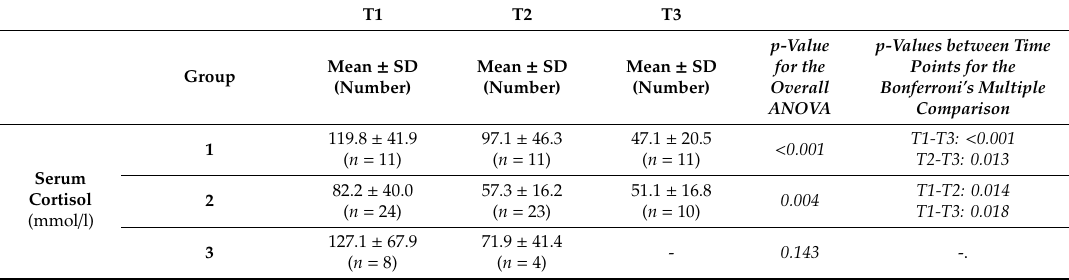
p-Value for the Overall